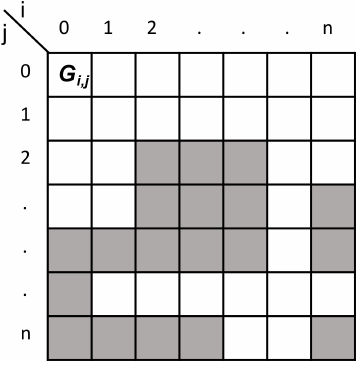
Figure 3. Fictive exclusion zone layer represented as an array: G i,j denotes one mesh point, white and gray squares indicate bad ( G i,j = 0) and good ( G i,j = 1) locations for a lidar installation, respectively, and i corresponds to x coordinate or easting and j cor- responds to y coordinate or